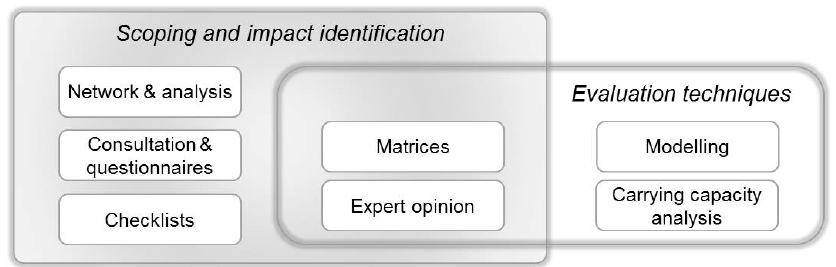
Figure 5. Methods and tools for assessment of indirect and cumulative impact as well as impact interaction (after Walker and Johnston 1999) [22].